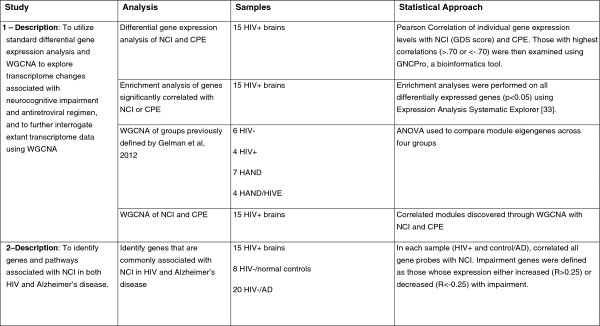
Overview of studies and analyses, in the order that they appear in the results.